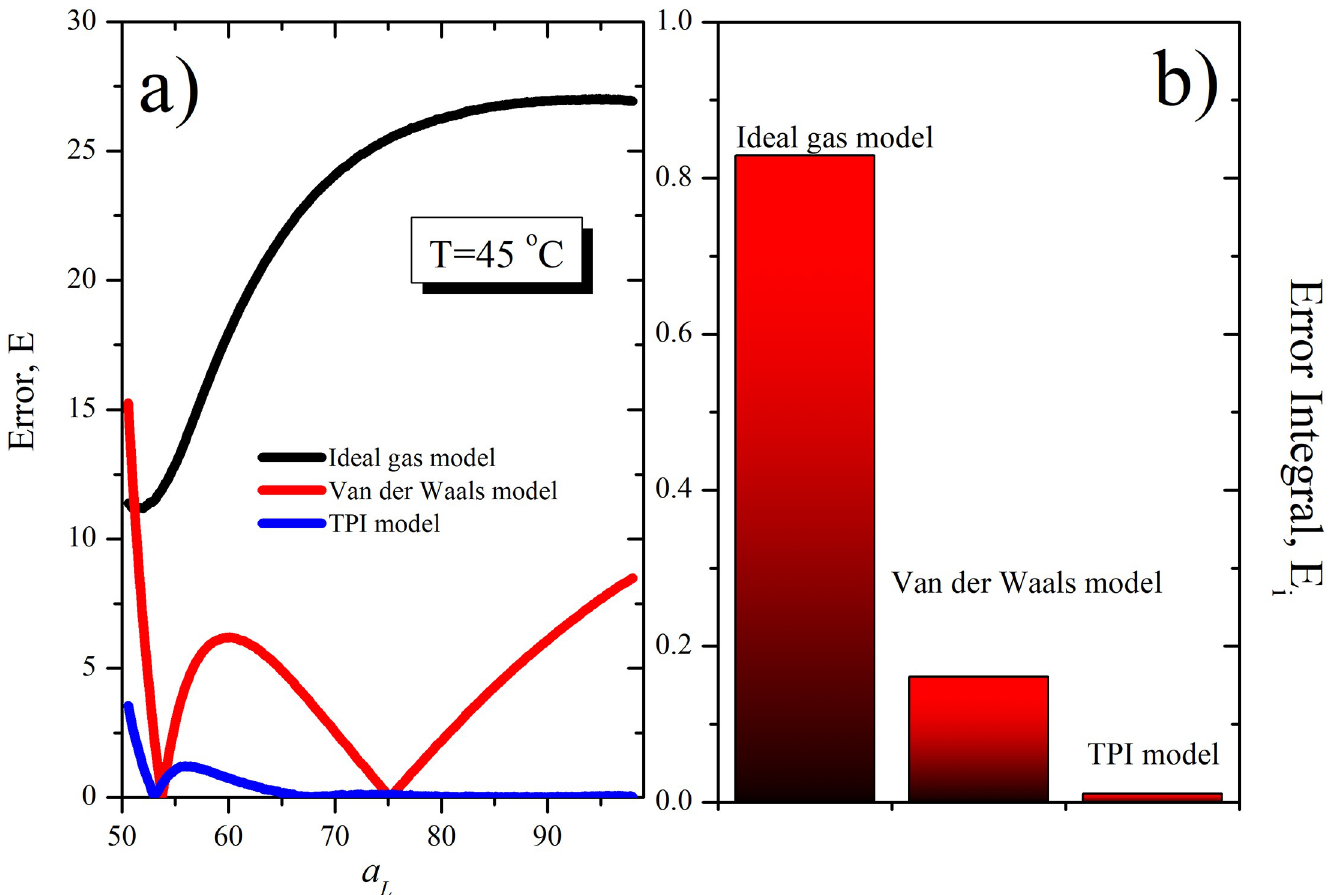
Fig 7. Errors at T = 45˚ C for ideal gas, van der Waals and TIP model. a) Error, E b) E int , integral error normalized. In both cases, TIP model has the smallest error.